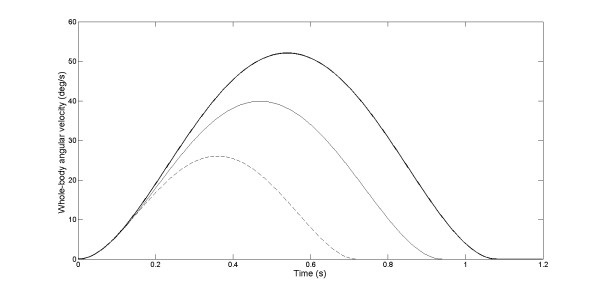
whole-body angular velocity: cognitive vestibular condition. Group mean time-series of the whole-body angular velocity for the chair rotation amplitude of 10° (dashed line), 20° (thin line) and 30° (thick line) are presented. Only counter-clockwise rotations are illustrated. Data are for the scoliosis group.